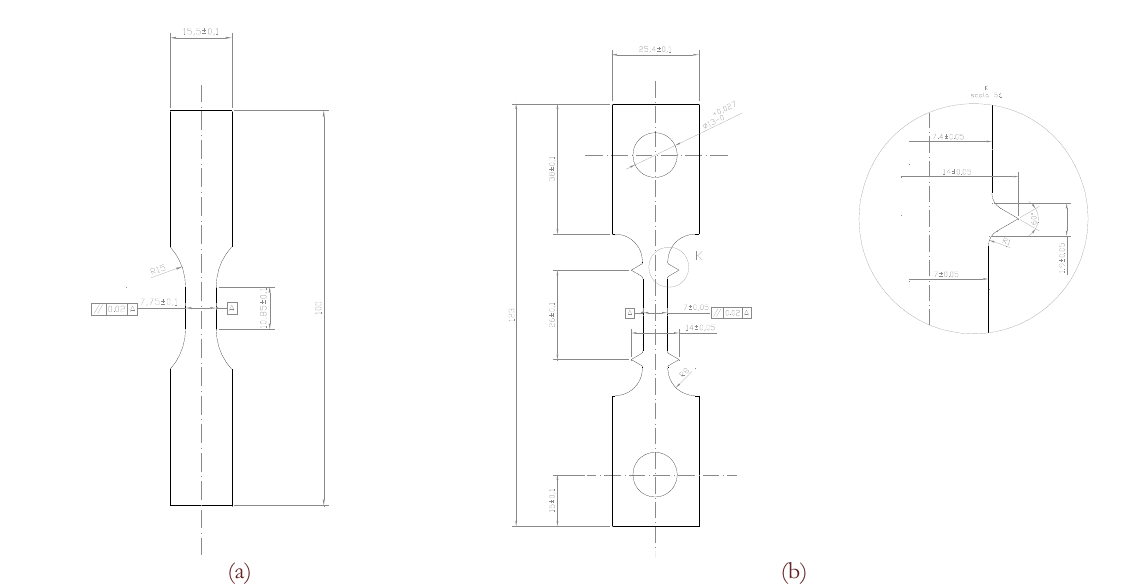
Figure 1: Specimen geometry for LCF test (a) and creep test (b).